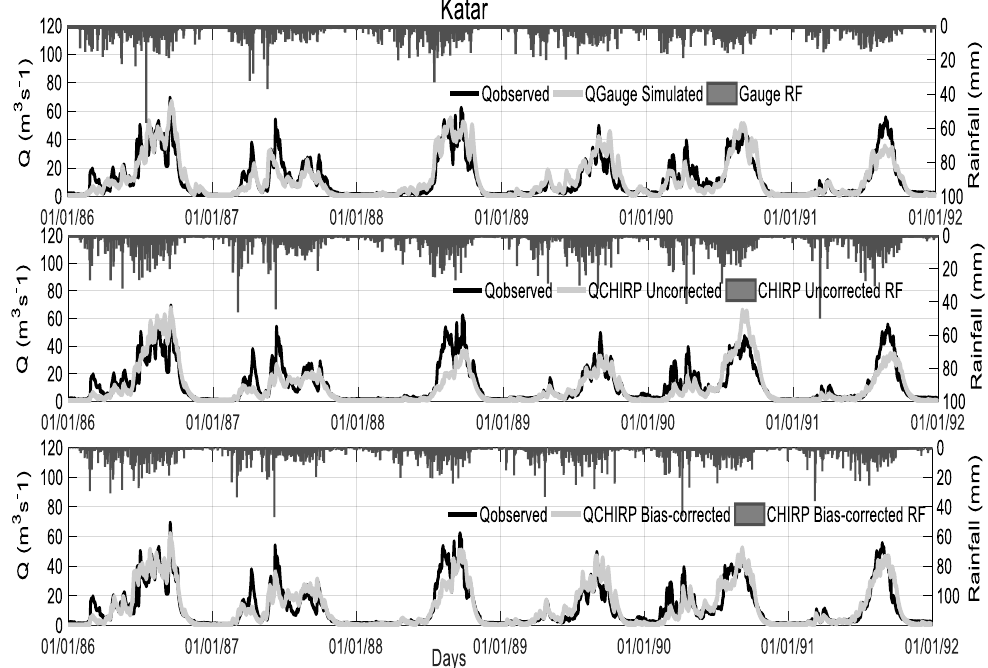
Figure 9. Model calibration results of Katar catchment (1986–1991) from gauge, uncorrected, and bias- corrected CHIRP satellite rainfall inputs.